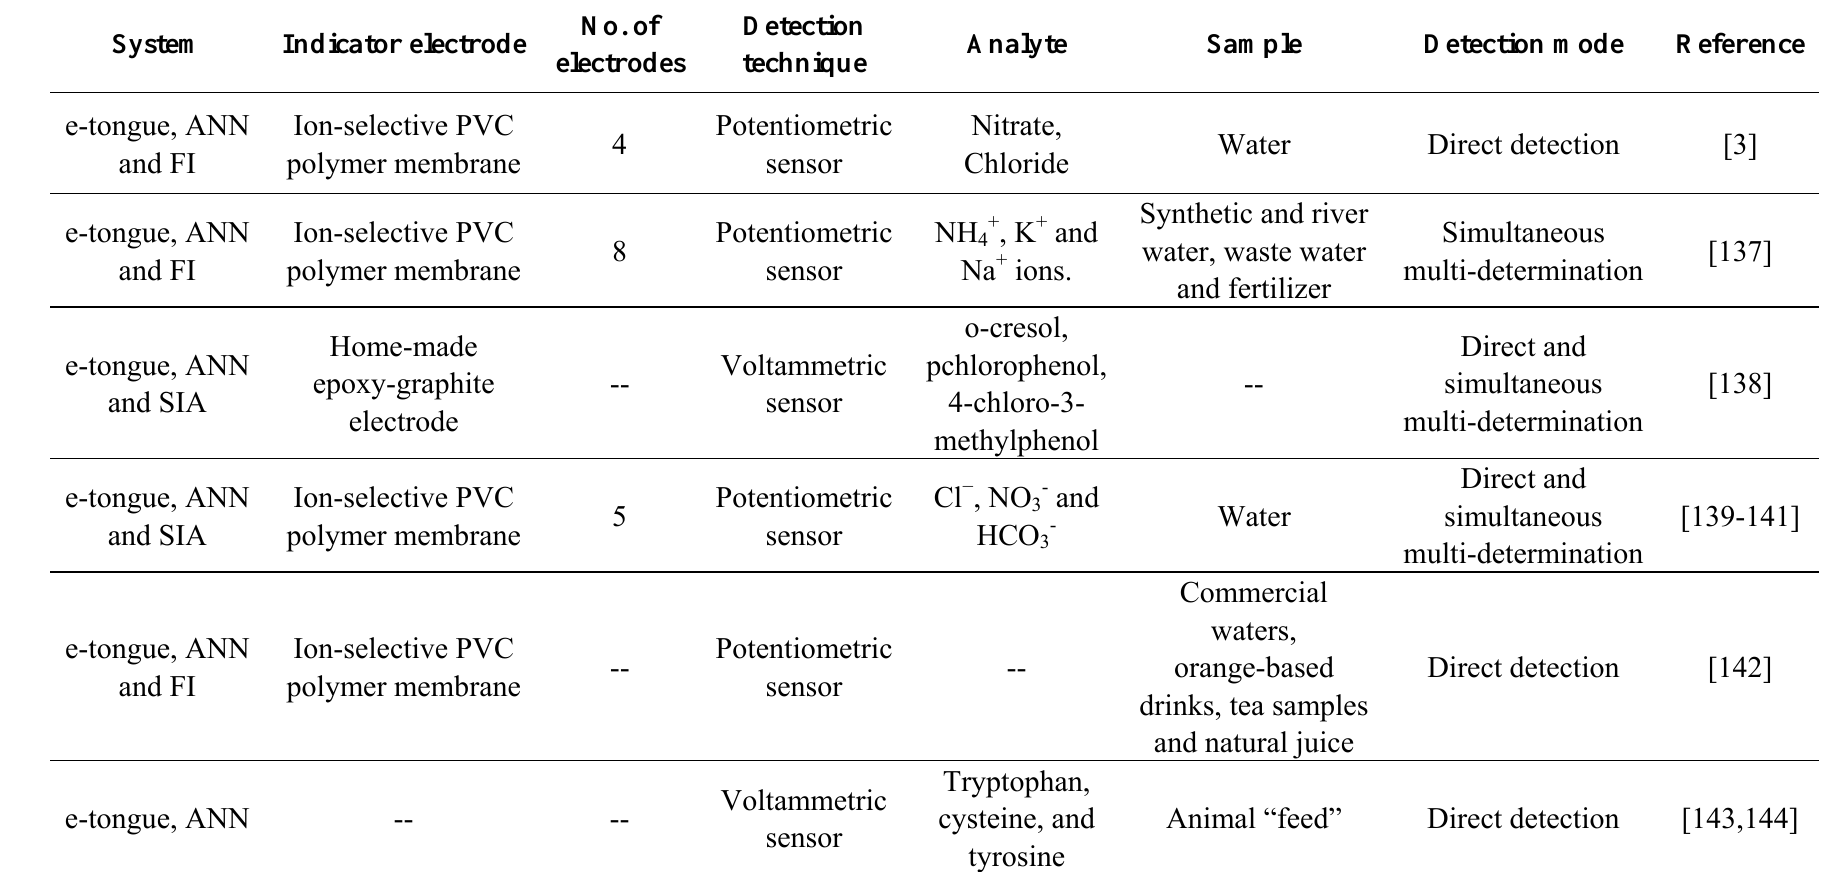
Table 2. Selective electronic tongue